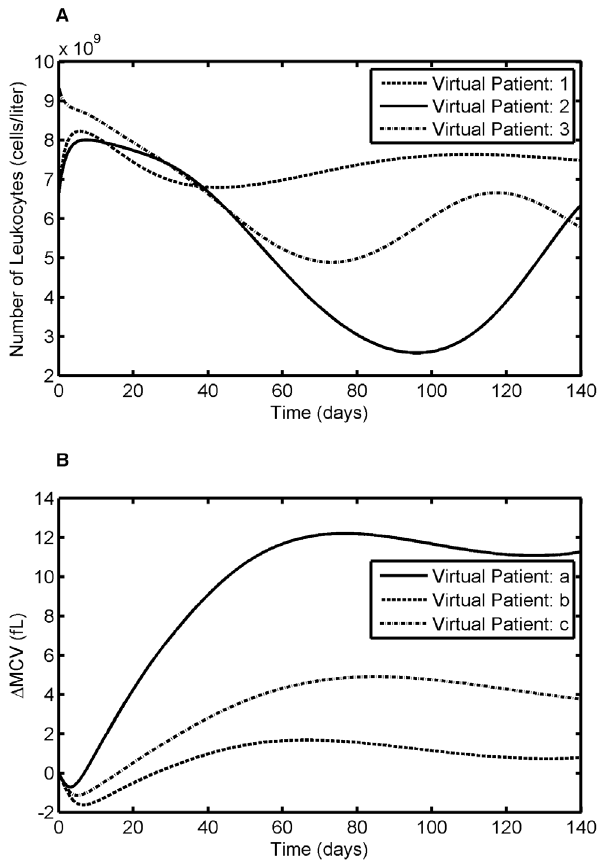
Figure 10. Virtual patient simulation for leukocyte and MCV model. Data for 6-MP model and leukocyte model are assumed to have originated from the same patient. The resultant estimated parameters for three representative patients are used to simulate the virtual patient response. It is apparent from the figure that different patients achieved different levels of response for the same dose, thereby achieving different treatment outcome. A. Leukocyte model, B. MCV model.